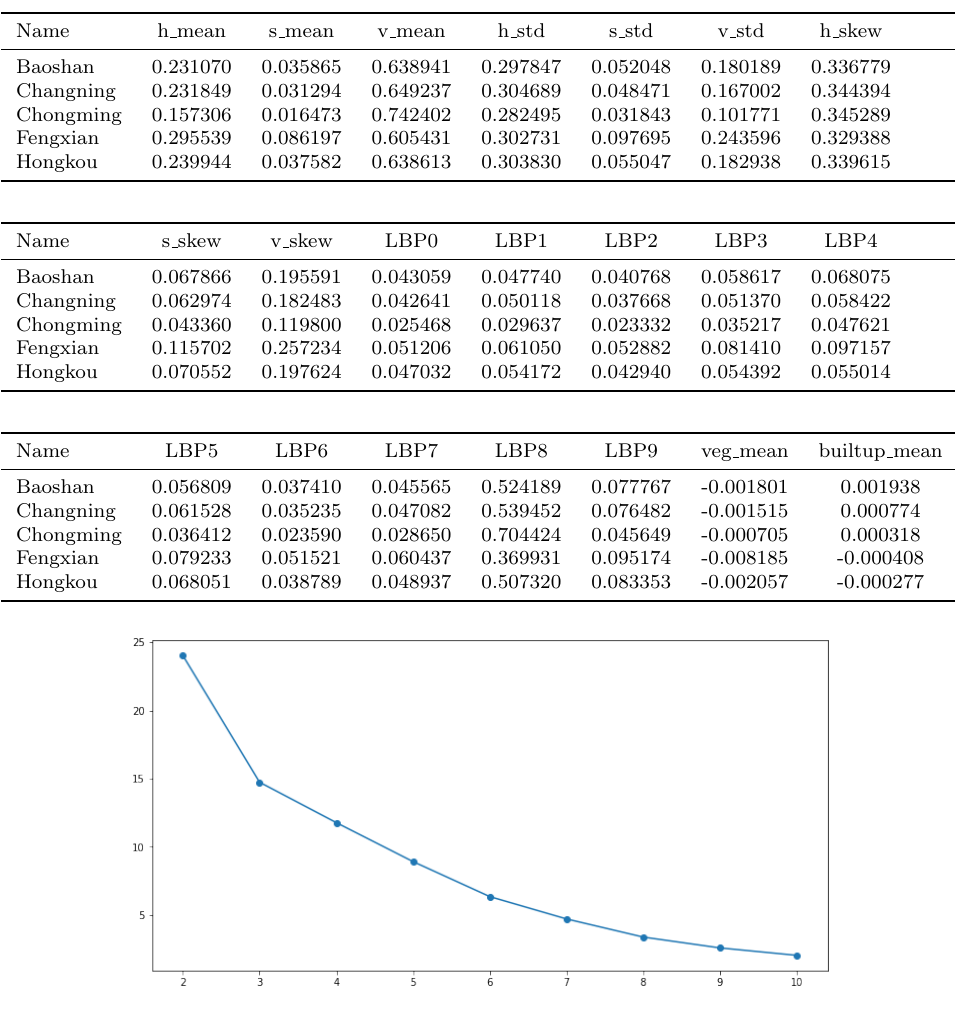
Figure 6: Elbow method to determine the optimal k for k-mean clustering Figure 6 indicates that 2 and 6 (i.e. knee in the plot) can be the optimal numbers of k clusters for the features extracted from both years of satellite imagery. Considering the context of the paper, the number of 6 is finally assigned to k to fit the kmeans clustering model, varying labels are subsequently matched to features